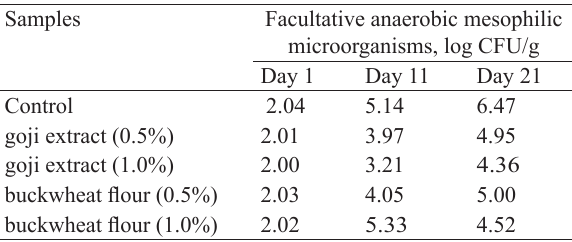
Table 4 Facultative anaerobic mesophilic microorganisms